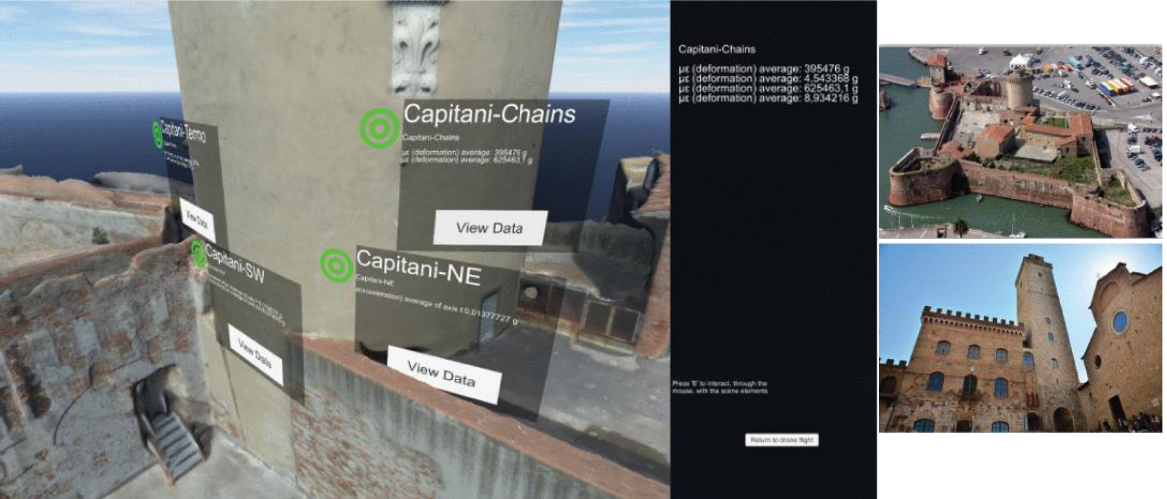
Figure 11. The VR environment: users can explore the virtual reconstruction of a monitored structure while having direct access to values measured by the sensors deployed on it [100].